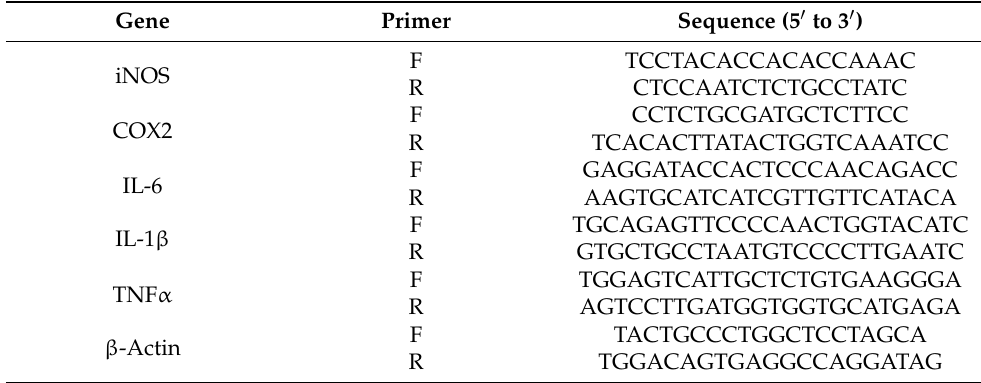
Table 1. Details of qRT-PCR primer used in this